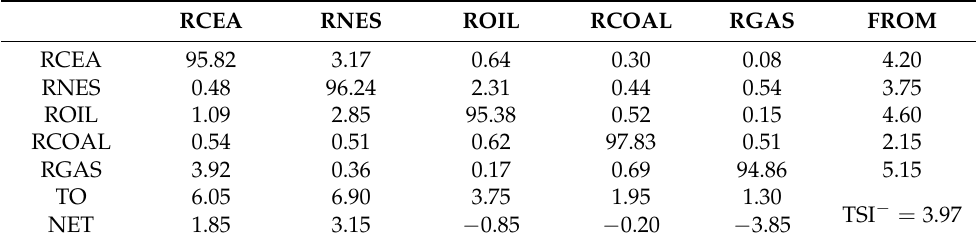
Table 5. The connectedness matrix of the negative return system.